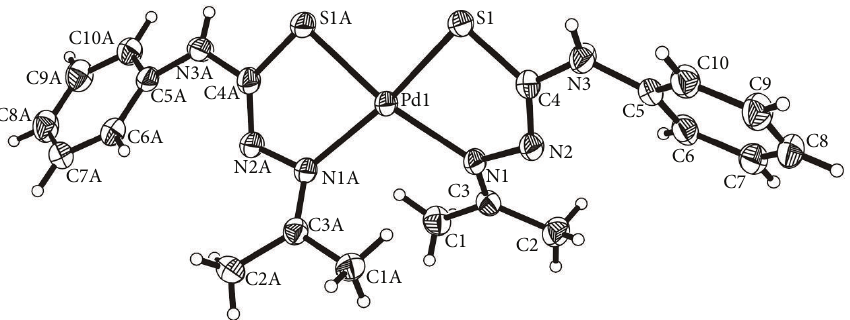
Figure 3: Molecular structure of [Pd(TSC 1 ) 2 ] ( 6 ). The displacement ellipsoids are drawn at the 50% probability. ( 𝜇 m) values a of the ligands HTSC 1 – 5 , palladium(II) complexes [ Pd(TSC 1 – 5 ) Table 4: IC 50 cell lines b .